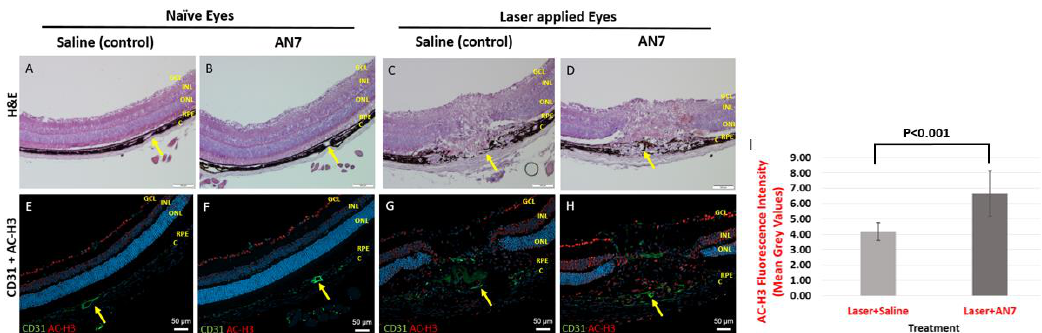
Figure 1. AN7 treatment elevates Histone H3 acetylation levels in laser-applied eyes. Representative images of cryosections from naïve eyes (without laser applications) of mice treated by intraperitoneal (IP) AN7 or saline (A,B,E,F) and lesions sites of laser-applied eyes of mice treated with IP AN7 or saline (C,D,G,H), from day 7 post laser application. ( A – D ) Hematoxylin and Eosin (H&E). Scale bar, 100 µ m. Yellow arrows mark the same blood vessel in the H&E and the corresponding immunostaining image to allow orientation. ( E – H ) Immunostaining for CD31 (green), acetylated histone H3 (AC-H3; red) and cells nuclei, DAPI (blue). GCL, Ganglion Cells Layer; INL, Inner Nuclear Layer; ONL, Outer Nuclear Layer; RPE, Retinal Pigmented Epithelium; C, Choroid. Scale bar, 50 µ m. ( I ) Quantification of AC-H3 staining in laser applied eyes.